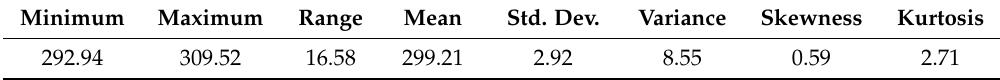
Table A2. Statistics of the air outlet temperature distribution [K], measured using “Tidbit” sensors. Minimum Maximum Range Mean Std. Dev.